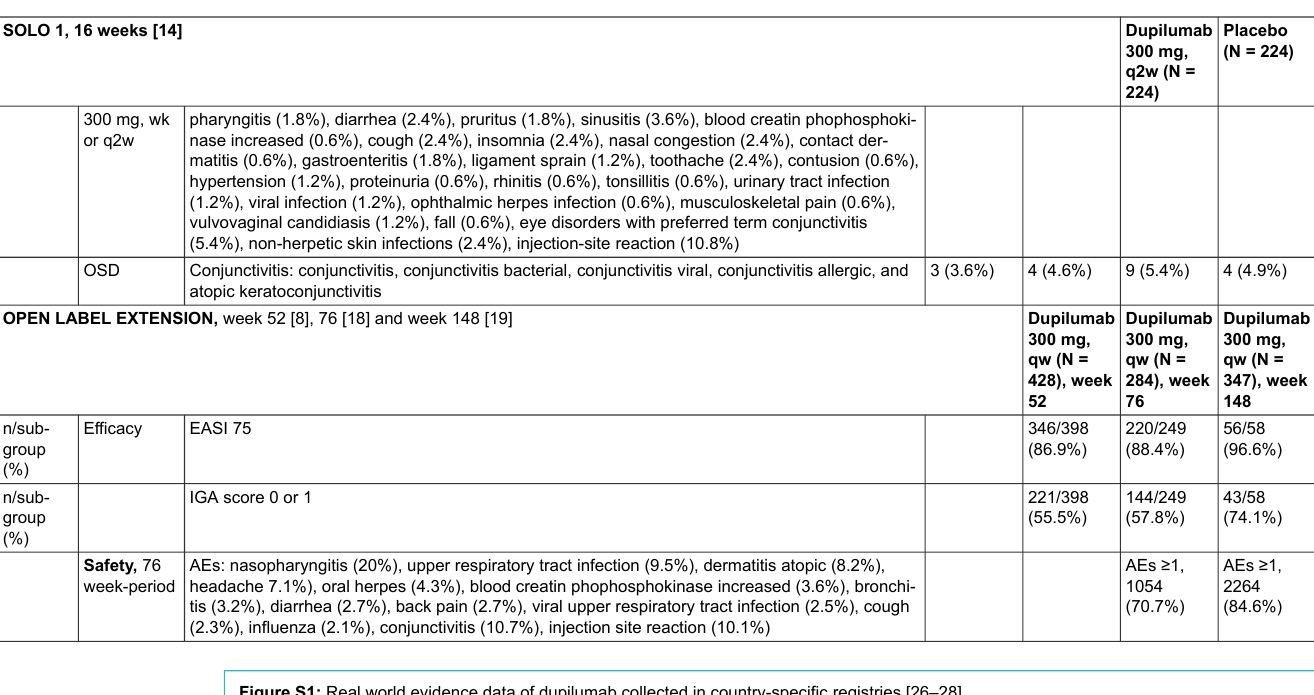
Figure S1: Real world evidence data of dupilumab collected in country-specific registries